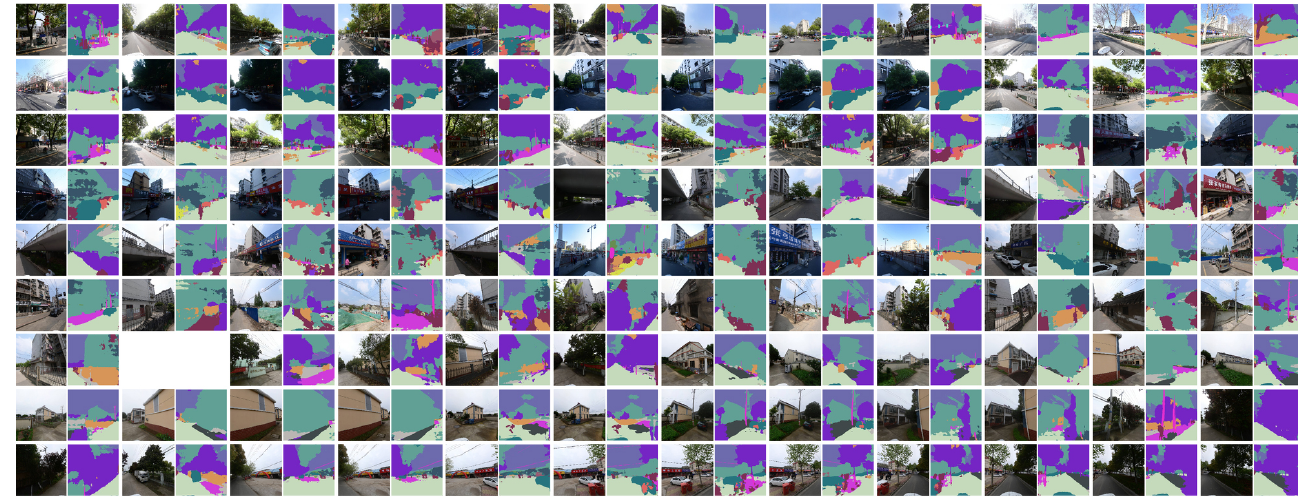
Figure 6. Semantic segmentation for the SVIs, coloring according to the